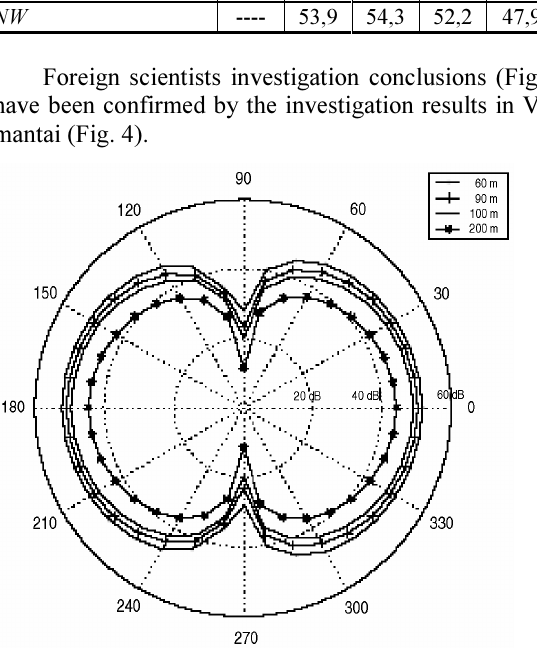
Fig. 3. Noise pressure level in different points in respect to the